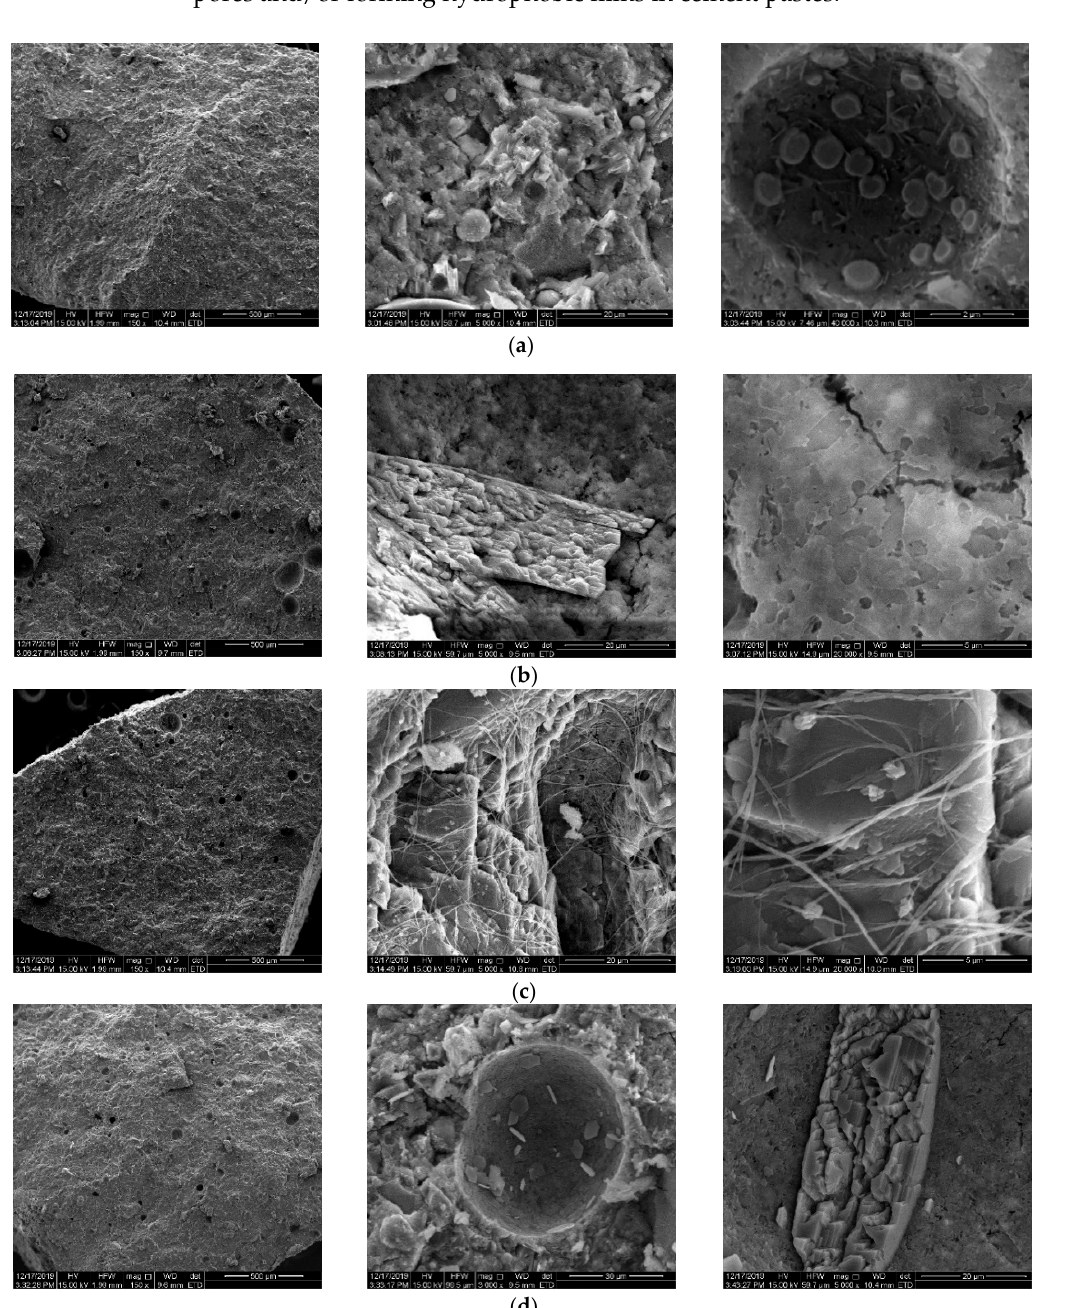
Figure 11. SEM pictures of cement pastes with different dosage of the NPI: ( a ) 0%, ( b ) 0.6%, ( c ) 0.9%, and ( d ) 1.2%.